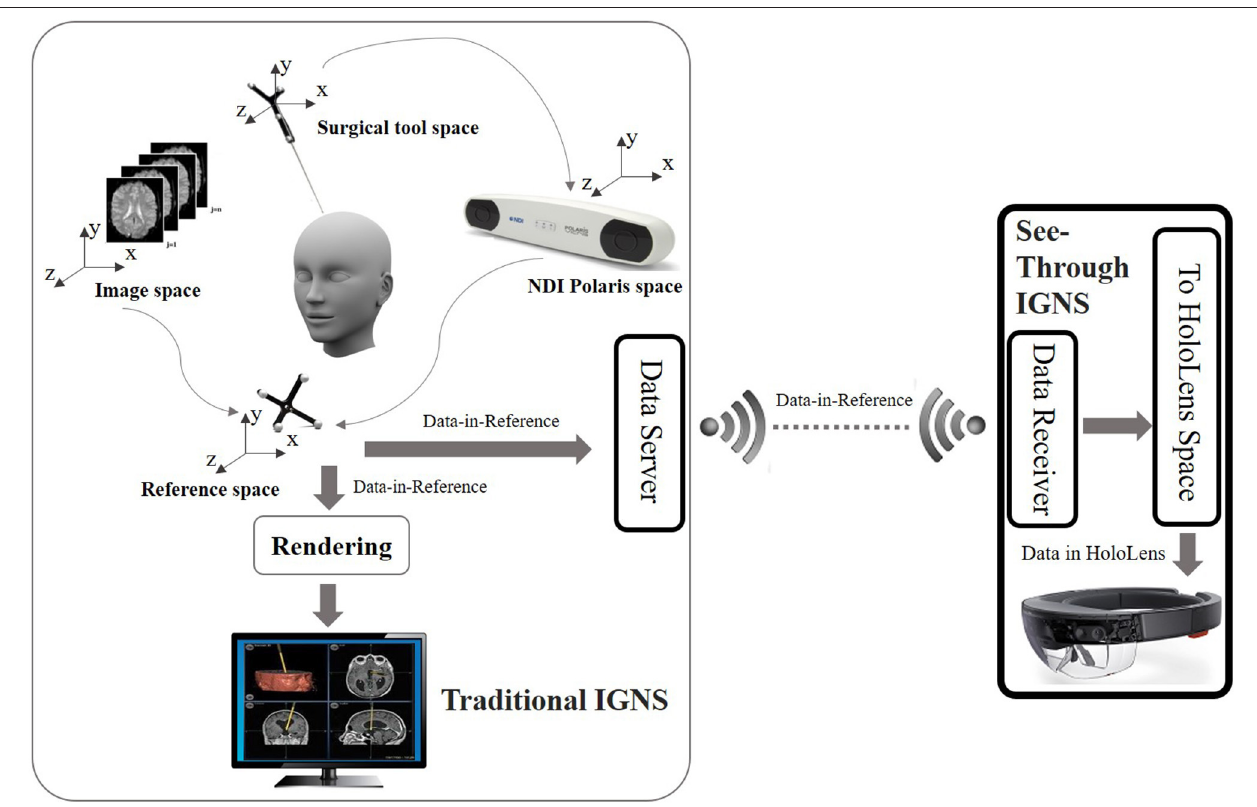
FIGURE 2 | Overview of the OST IGNS framework. The left part is similar to traditional IGNS with the inclusion of a data server. The right part is the OST portion which includes a data receiver, a spatial registration method for conversion of objects to HoloLens space, and HoloLens rendering. The data server and data receiver communicate